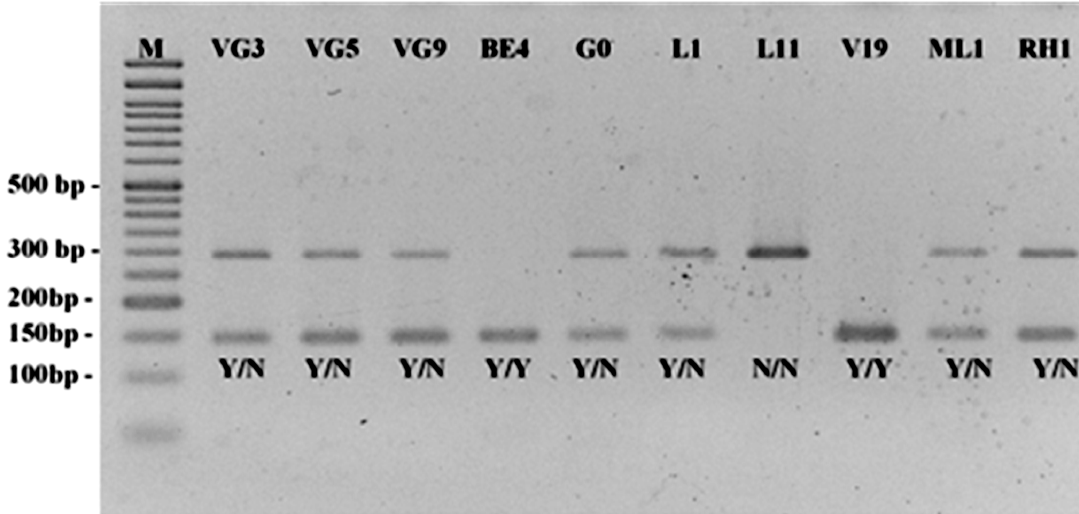
Figure 3. SNP locus OM145551. SNP-CAPS patterns of 10 A. unedo accessions using the TaqI restriction enzyme. Y/N—only one allele cut (heterozygous). Y/Y—both alleles cut (homozygous). N/N—Both alleles not cut (homozygous). Notice that the restriction with the enzyme TaqI results in two fragments of, respectively, 145 and 147 nucleotides fused in one single (lower) band. M—Ladder VI (Nzytech, Lisboa, Portugal).